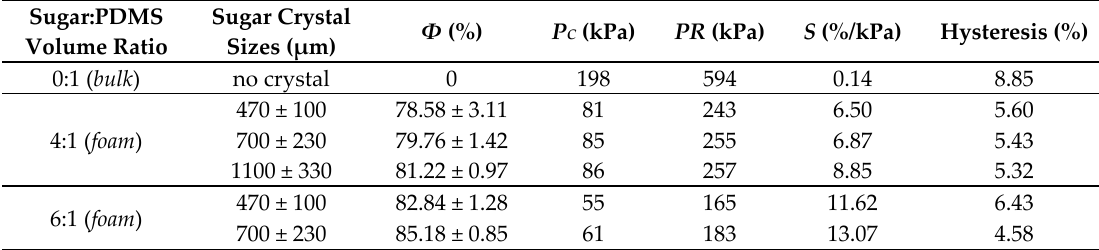
Table 1. All fabricated PDMS samples (bulk films or foams) are 6 ± 0.5 mm thick. Table 1. Variation of the relative permittivity of the microporous PDMS as function of the porosity.